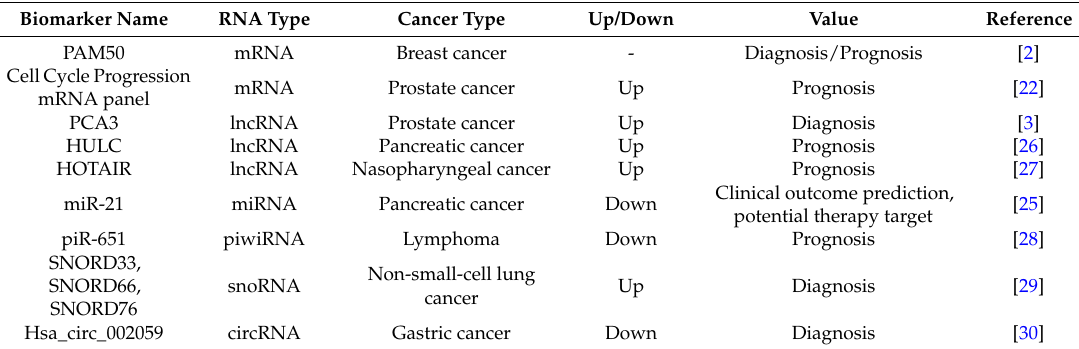
Table 2. Tissue-based RNA biomarkers for